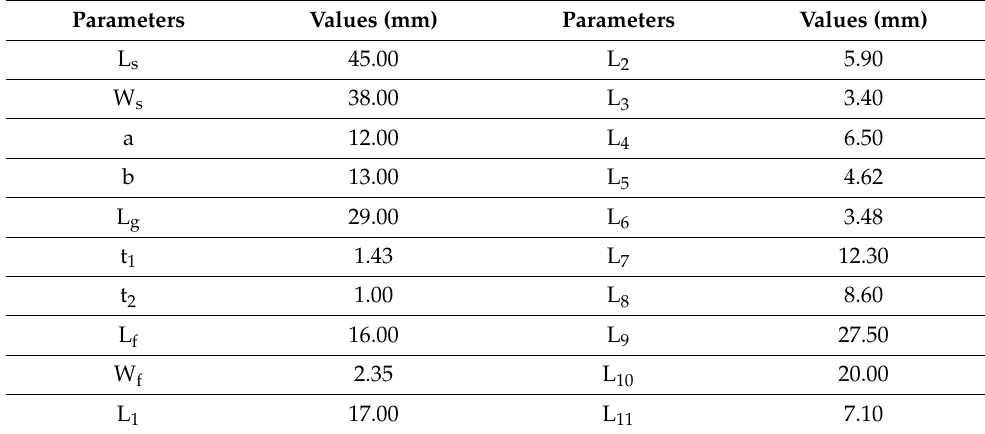
Table 1. The optimized dimensions of the proposed